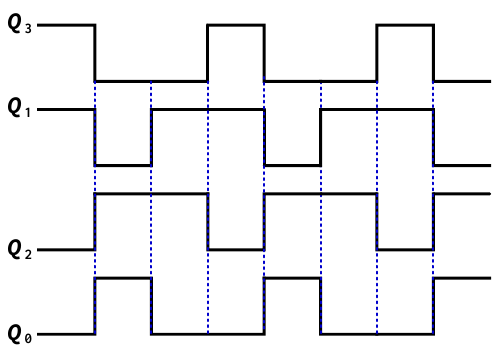
Figure 11. Switching sequences of the proposed equalizer without using Q 4 at V B 0 < V B 1 .